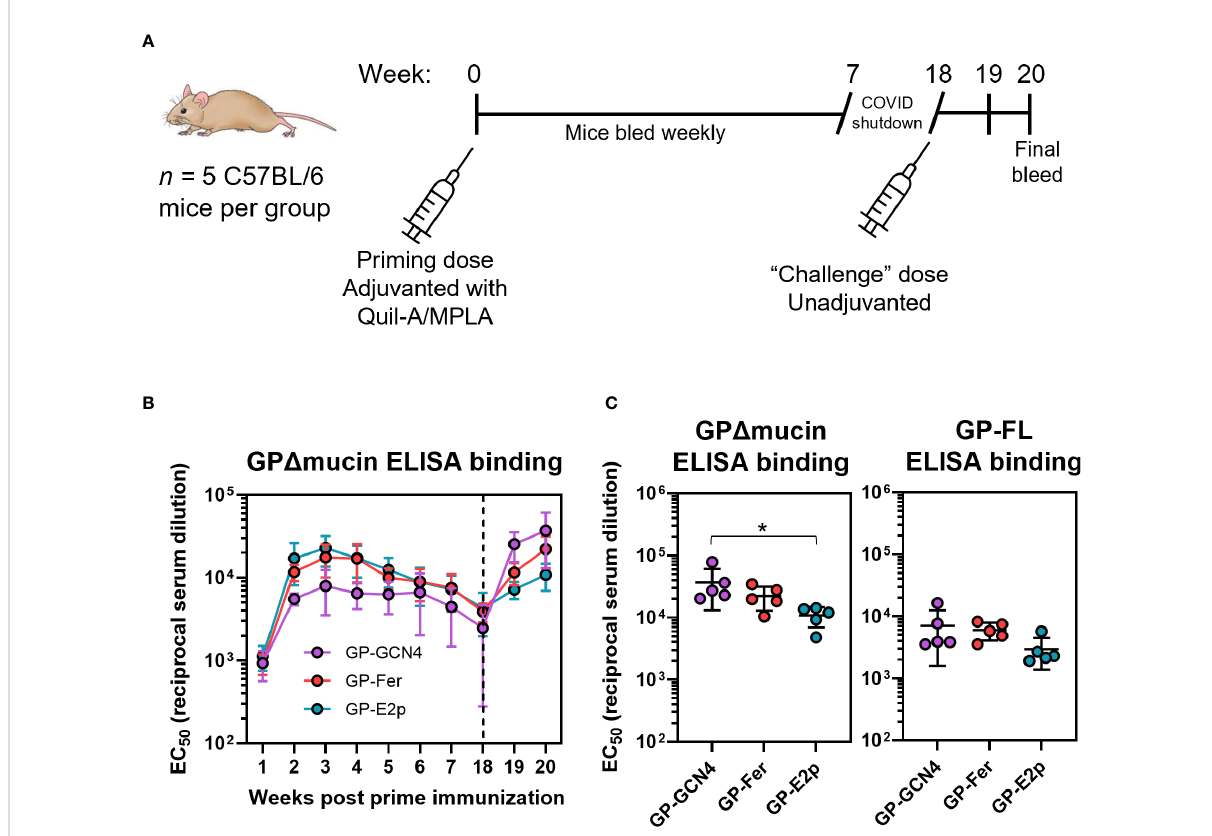
FIGURE 3 GP D mucin nanoparticles rapidly elicit antigen-speci fi c antibodies in vivo. (A) Immune responses to GP D mucin antigens were assessed in C57BL/6 mice (n = 5 per antigen). Mice were immunized at day 0 with 5 µg antigen formulated with 10 µg Quil-A and 10 µg MPLA. Blood was collected weekly from weeks 1 to 7 post prime immunization. Mice were challenged with an unadjuvanted dose of 5 µg GP-GCN4 as a proxy for pathogen exposure. Mice were bled one week post second dose and sacri fi ced two weeks post second dose. (B) Weekly bleeds were analyzed using ELISAs to compare antigen- speci fi c responses between GP-GCN4, GP-Fer, and GP-E2p. Each point represents the mean EC 50 titer for each group at each time point and error bars represent the standard deviation. ELISAs were performed in experimental duplicate. (C) Final bleeds were assessed for both GP D mucin and FL GP titers via ELISA. Each point represents the EC 50 value per animal and error bars represent the standard deviation. Statistical analysis was performed using ordinary one-way ANOVA with Tukey ’ s multiple comparisons test (* = p ≤